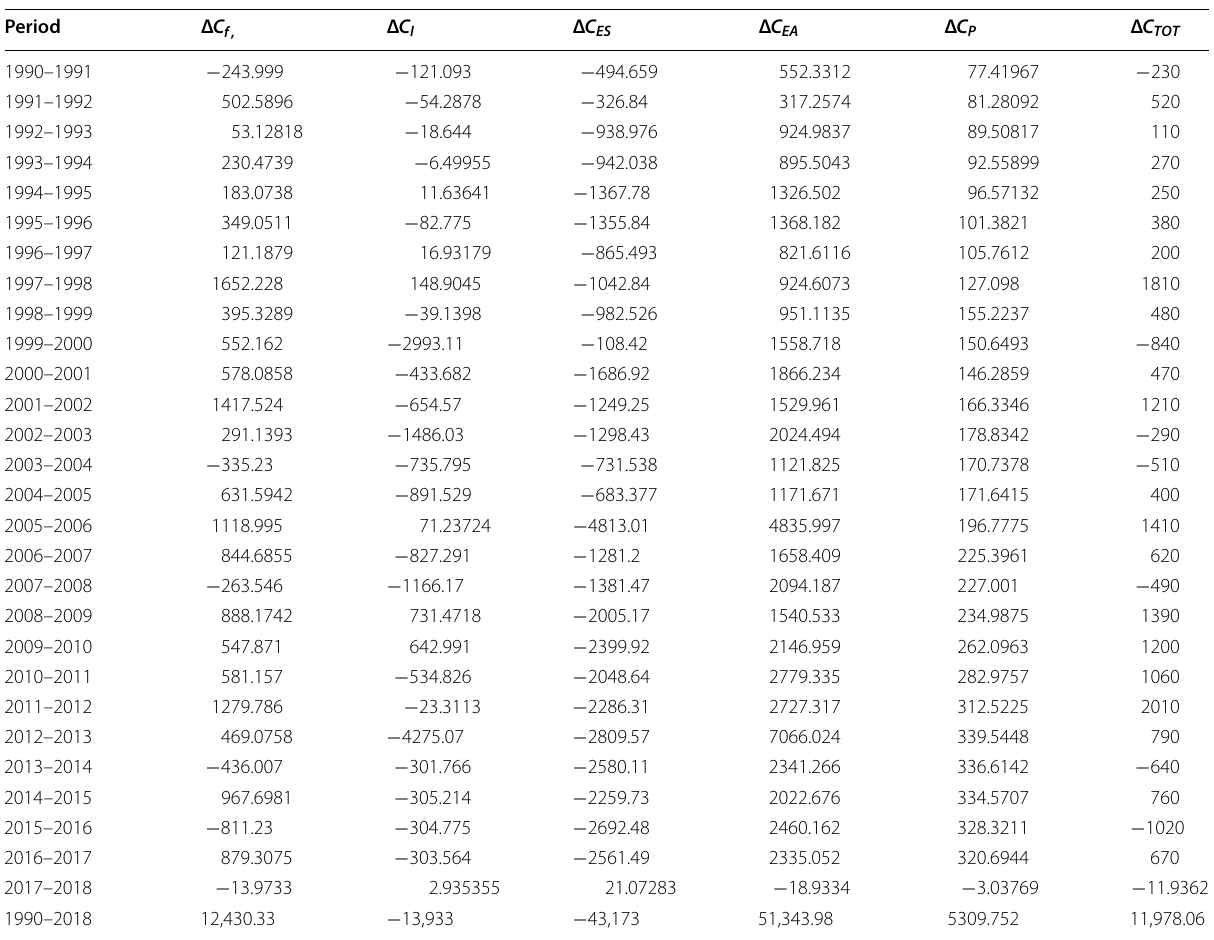
Table 6 Drivers of changes in total CO